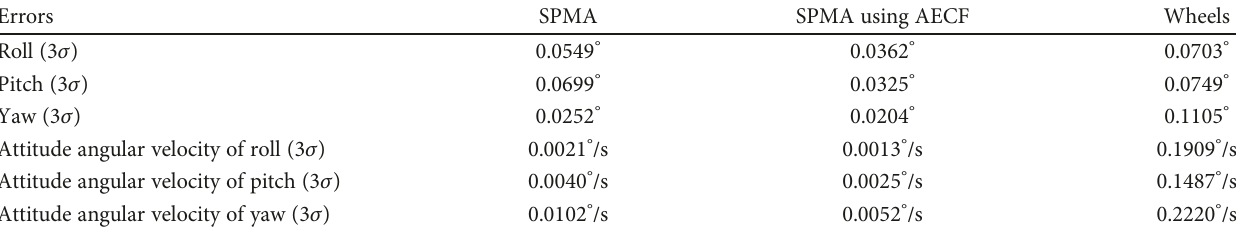
Table 1: Comparisons among SPMA, SPMA with AECF, and